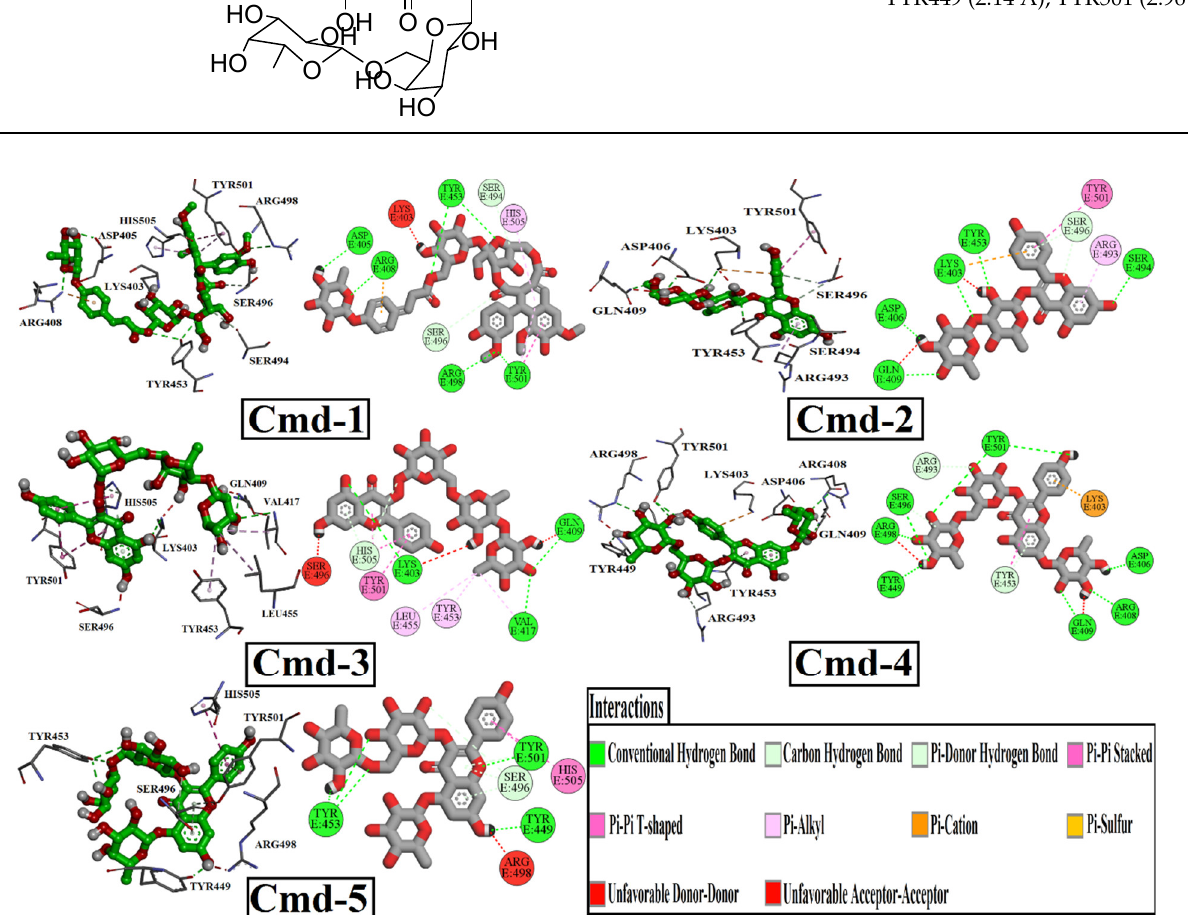
Figure 1. The 2D and 3D representations of the anticipated binding poses of the best-investigated phytochemical Cmds inside the active site of Omicron BA.1. In detail, Cmd-1 (docking score = −9.7 kcal/mol) formed a carbon-hydrogen bond with SER494 (3.35 Å), and SER 496 (3.75 Å). Interaction of pi-pi stacked type with TYR501 (4.74 Å). Interaction of pi-alkyl with TYR501 (4.45 Å) and HIS505 (4.57 Å). Cmd-1 formed six conventional hydrogen bonds with ASP405 (2.28 Å), ARG408 (2.80 Å), TYR453 (2.86, 3.13 Å), ARG498 (3.31 Å), and TYR501 (3.10 Å). Cmd-2, with a docking score of −9.5 kcal/mol, exhibited a featured pi-cation interaction with LYS403 (4.85 Å). It also formed pi-pi stacked and pi-alkyl interactions with TYR501 (5.50 Å) and ARG493 (4.58 Å), respec- tively. It also formed a carbon-hydrogen bond with SER496 (3.71 Å), a pi-donor hydrogen bond with the same residue at 4.02 Å, and several conventional hydrogen bonds with the following residues: LYS403 (2.99 Å), ASP406 (2.02 Å), GLN409 (3.08 Å), TYR453 (3.06 Å), SER494 (3.22 Å). Cmd-3, with a docking score of −9.2 kcal/mol, interacted with TYR501 in two ways: pi-pi stacked (4.41 Å) and pi-pi T-shaped (4.84 Å). It also interacted with HIS505 in a pi-pi T-shape (4.21 Å). Pi-alkyl interaction was observed with three different amino acid residues, VAL417 (4.29 Å), TYR453 (4.83 Å), and LEU455 (5.10 Å). It formed three main conventional hydrogen bonds with the following residues: LYS403 (3.22 Å), GLN409 (2.83 Å), and VAL417 (3.27 Å). Cmd-4 and Cmd-5 obtained the same docking score (−9.0 kcal/mol). However, they interacted with different residues inside the binding pocket. As in Cmd-2, Cmd-4 also showed pi-cation interaction with LYS403, but at different dis- tances. Cmd-4 recorded one pi-pi T-shaped interaction with TYR453 (5.62 Å) and one pi- donor hydrogen bond with the same residue at 3.98 Å. One Carbon-hydrogen bond was detected with ARG493 at 3.67 Å. Cmd-4 exhibited eight conventional hydrogen bonds with ASP406 (2.13 Å), ARG408 (2.92 Å), GLN409 (2.90 Å), TYR449 (2.45 Å), SER496 (3.01 Å), ARG498 (3.09 Å), and TYR501 (2.75, 3.13 Å). Regarding Cmd-5, TYR453 and SER496 were detected as the main residues of interaction as they formed three conventional hy- drogen bonds and three carbon-hydrogen bonds, respectively. One pi-donor hydrogen bond was noticed with TYR501, one pi-pi stacked interaction with the same residue, and one pi-pi-T-shaped interaction with HIS505 was also detected.